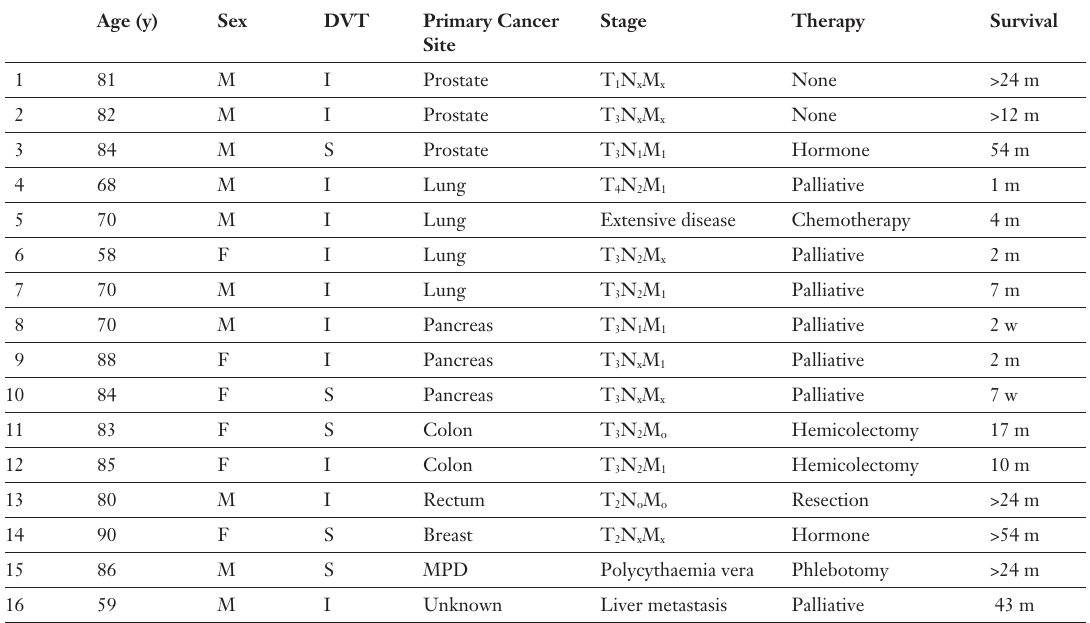
Table 2 Malignant disorders detected in patients with deep venous thrombosis during index hospitalisation (prevalent cancers).